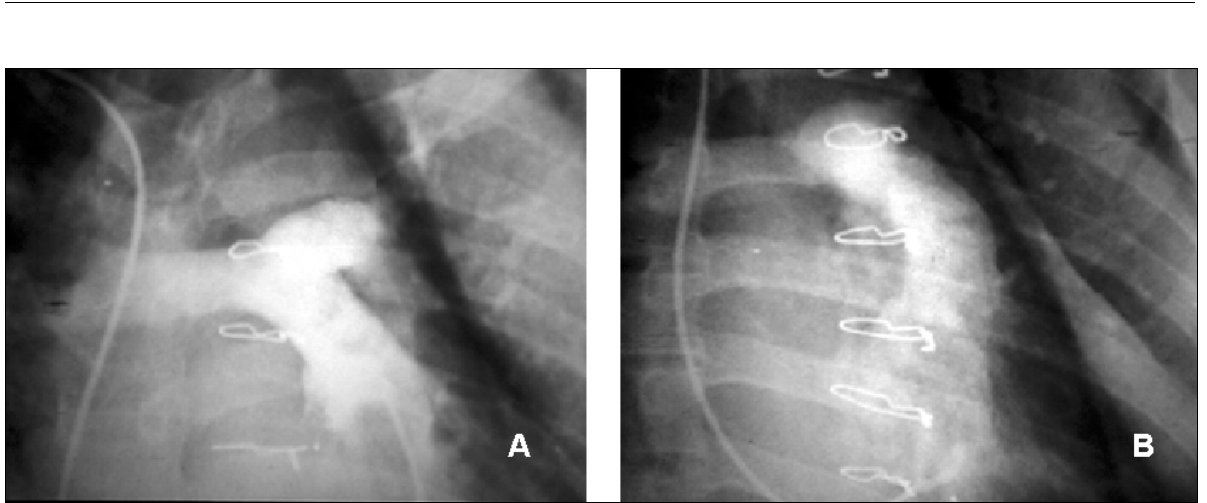
Fig. 5 - A- Injeção de contraste em homoenxerto pulmonar utilizado na reconstrução da via de saída do ventrículo direito. Não se evidencia nenhum grau de estenose tanto proximal como distal. B- Ventriculografia direita no mesmo paciente.